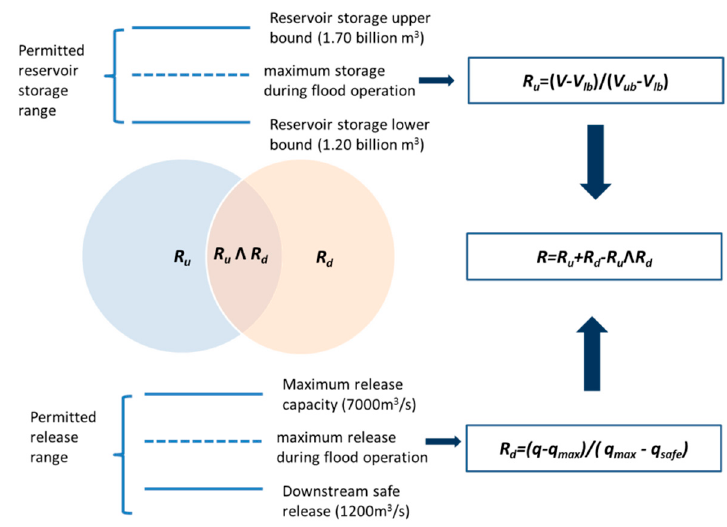
Figure 5. Illustration of upstream risk R u , downstream risk R d , and their integration R .